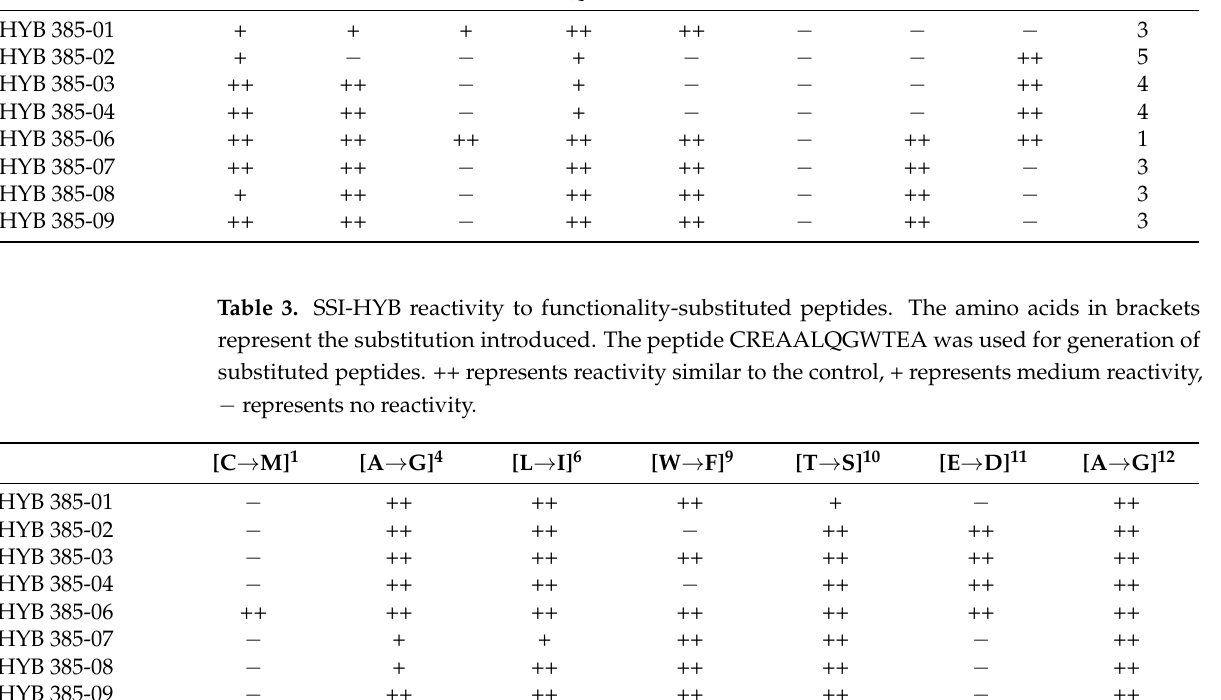
Table 2. SSI-HYB reactivity to Ala-substituted peptides. Amino acids in brackets represent the amino acid substituted by Ala. N represent the number of substitutions that were not tolerated in relation to obtaining antibody binding. The peptide CREAALQGWTEA was used for generation of substituted peptides. ++ represents reactivity similar to the control, + represents medium reactivity, − represents no reactivity.